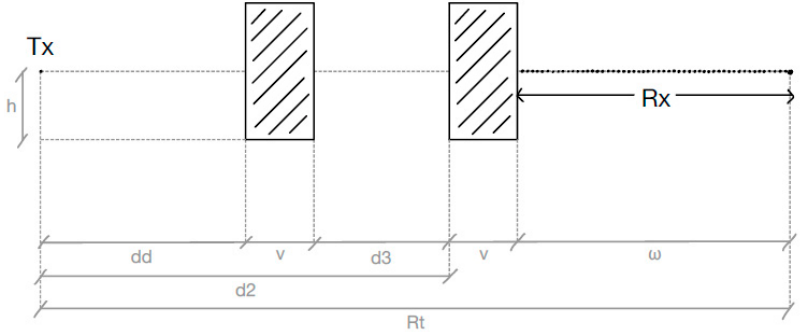
Figure 15. Scheme of the first considered NLOS scenario.